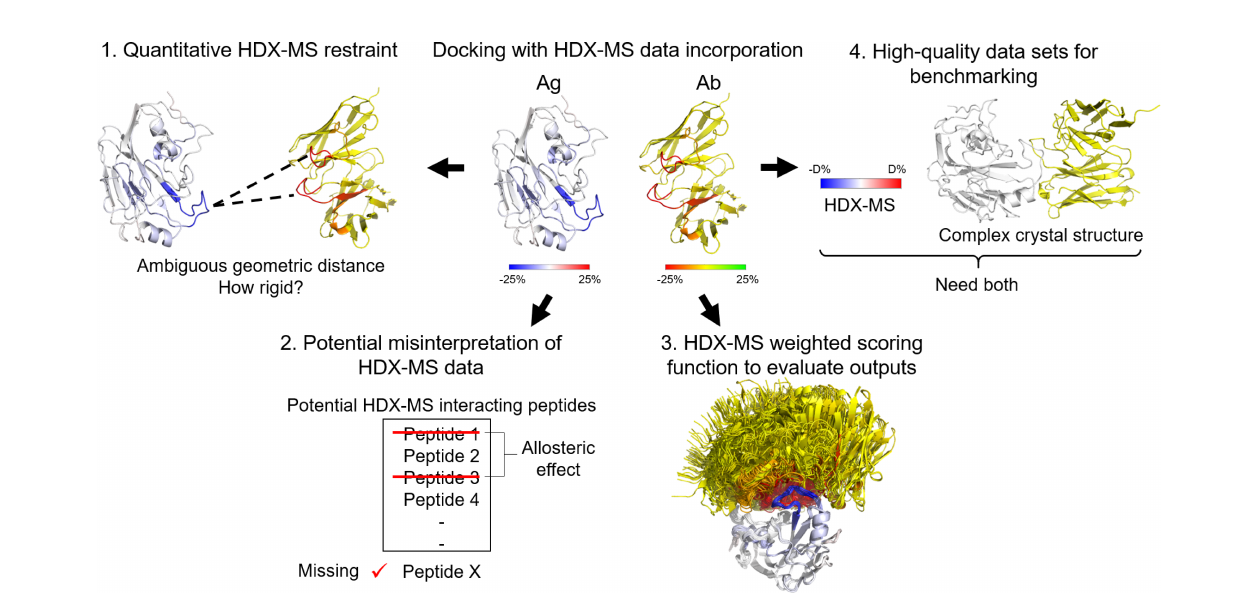
FIGURE 7 | Challenges of HDX-MS data incorporation into docking. 1) Quantitative HDX-MS restraint: HDX-MS data is incapable of providing quantitative geometric distances between atoms, thus, hindering its application to the sampling process. 2) Potential misinterpretation of HDX-MS data. True positive signals can be undetected due to insuf fi cient coverage and inherent blind spots or overlooked. False positive signals are very probable due to manual data interpretation, noise, and allosteric effects. 3) HDX-MS weighted scoring function. The evaluation of docking poses based on HDX-MS data is still largely qualitative. 4) High-quality dataset for benchmarking. HDX-MS data and crystal structure of an Ab-Ag complex in most cases are exclusively available. There is a need for establishing a database for HDX- MS epitope mapping